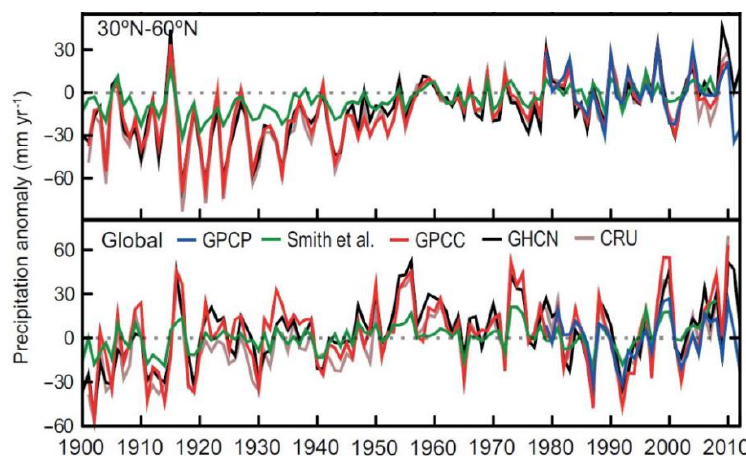
Figure 3. The global annual mean land-surface air temperature anomalies from the four datasets of Berkeley, CRUTEM, GHCN, and GISS, compared to the period of 1961–1990 (Source: IPCC report, 2013 [60]).